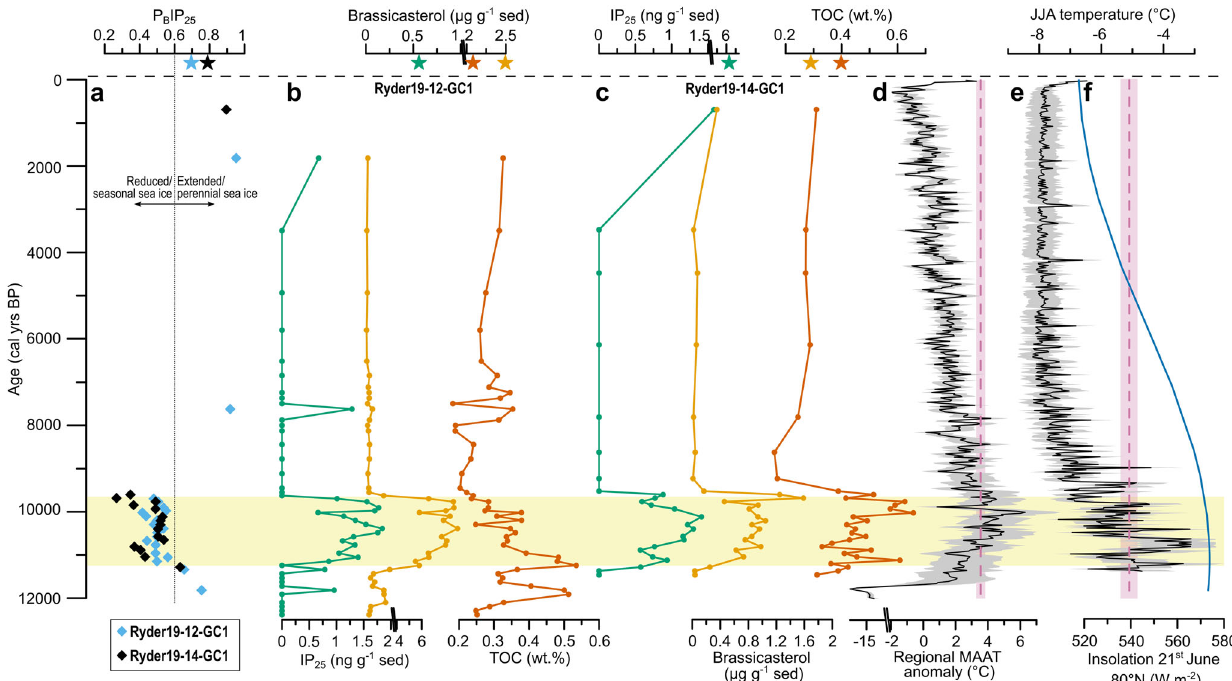
Fig. 2 Sea-ice biomarkers and TOC from two sites in the Lincoln Sea alongside regional atmospheric temperatures across the Holocene. a P B IP 25 in Ryder19-12-GC1 (light blue diamonds) and Ryder19-14-GC1 (black diamonds). b IP 25 (green), brassicasterol (yellow), and TOC (orange) in Ryder19-12-GC1. c IP 25 (green), brassicasterol (yellow), and TOC (orange) in Ryder19-14-GC1. d Mean annual air temperature anomaly (MAAT) at Agassiz ice cap compared to pre-industrial (PI; Supplementary Methods 1.2) (black) including the 2 σ uncertainty envelope (grey) 61 . MAAT was reconstructed based on the oxygen isotopic signature ( δ 18 O) in the ice 61 . Additionally the mean of the Early Holocene time period with evidence for seasonal sea-ice (dashed pink) with the corresponding 95% con fi dence interval (light pink) is shown. e Reconstructed June-August temperatures at Agassiz ice cap (black) based on the melt layer record including the 2 σ uncertainty envelope (grey) 61 and the mean of the Early Holocene time period with evidence for seasonal sea-ice (dashed pink) with the corresponding 95% con fi dence interval (light pink). f 21 st of June insolation at 80°N 95 (blue). The stars above the horizontal dashed line show P B IP 25 (light blue, black), IP 25 (green), brassicasterol (yellow), and TOC (orange) in the surface samples of Ryder19-12-MC1-8 and Ryder19-13- MC1-5 (Fig. 4). The horizontal light yellow bar marks the Early Holocene interval characterized by seasonal sea-ice in the southern Lincoln